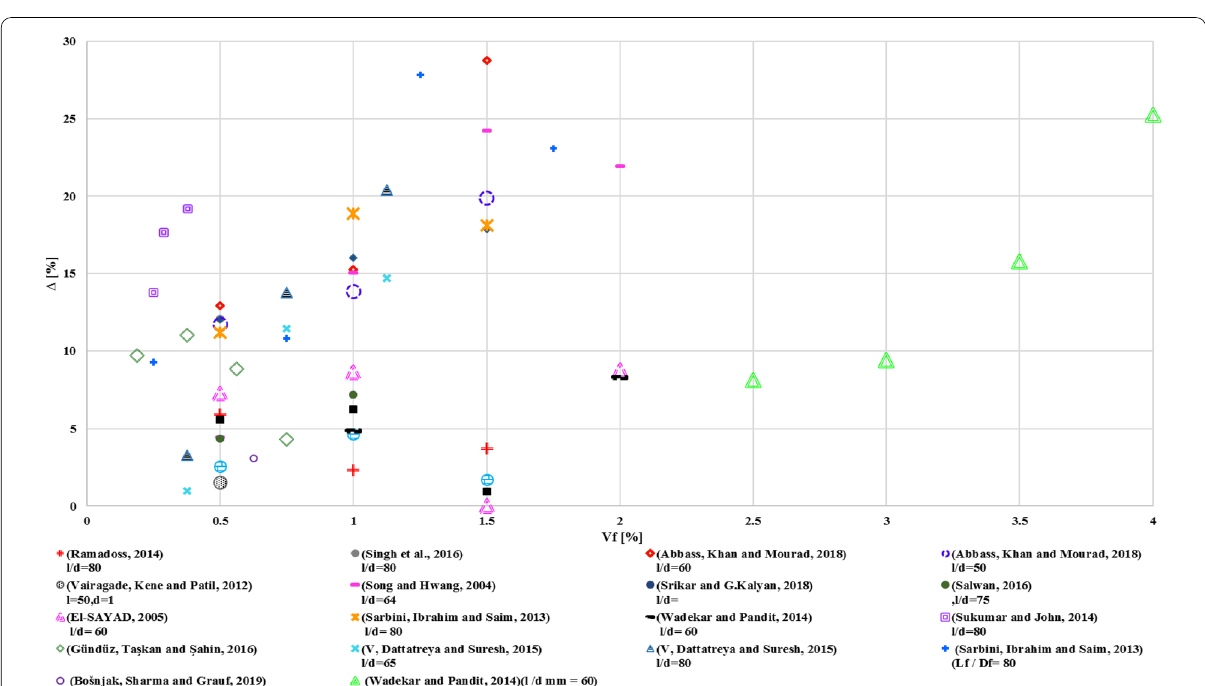
Fig. 6 Comparison of evaluated tensile strength and previous experimental